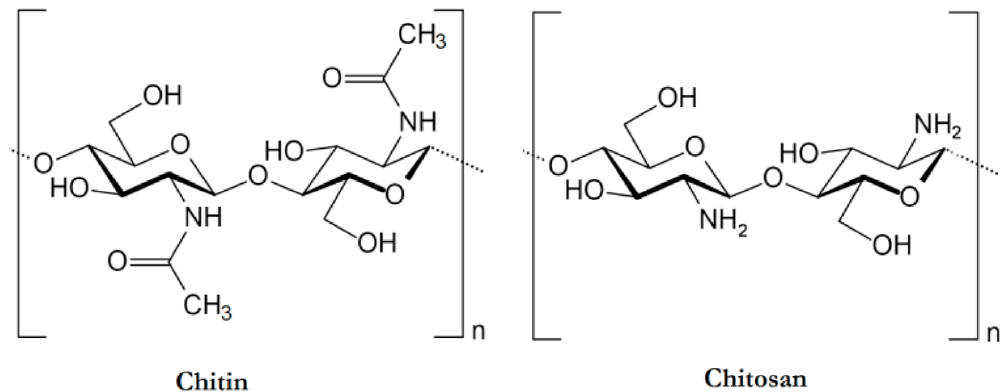
Figure 1. Structure of chitin (poly(b-(1-4)- N -acetyl- D -glucosamine)) and deacetylated chitin (chitosan). Reprinted from [27] under CC BY 4.0 license.